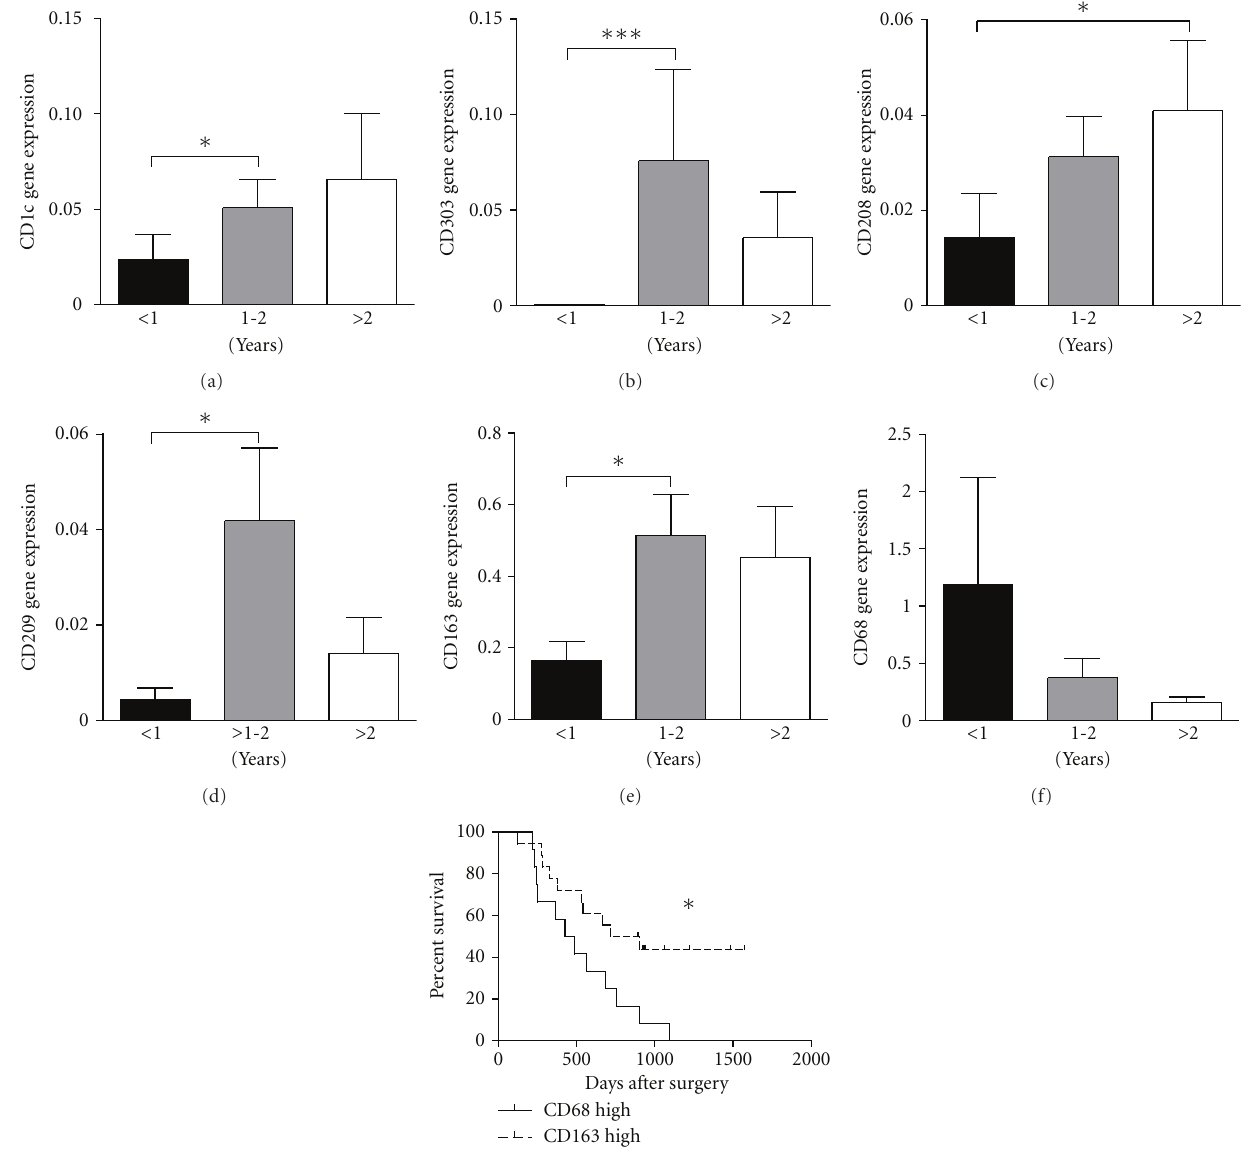
Figure 6: The expression levels of dendritic cell and macrophage markers might predict the PDAC patient survival. The PDAC patients were divided into three groups based on their survival time after tumor resection (less than one year ( n = 9), between 1 and 2 years ( n = 10), and more than two years ( n = 11)). The gene expressions of CD1c (a), CD303 (b), CD208 (c), CD209 (d), CD163 (e), and CD68 (f) were compared between each group. The patients were also divided into two groups based on if the main expression of macrophage markers was CD68 ( n = 12) or CD163 ( n = 18) (g). Log-rank (Mantel Cox) test was used for calculation of P value. ∗ P < 0 . 05, ∗∗ P < 0 . 05, ∗∗∗ P < 0 .